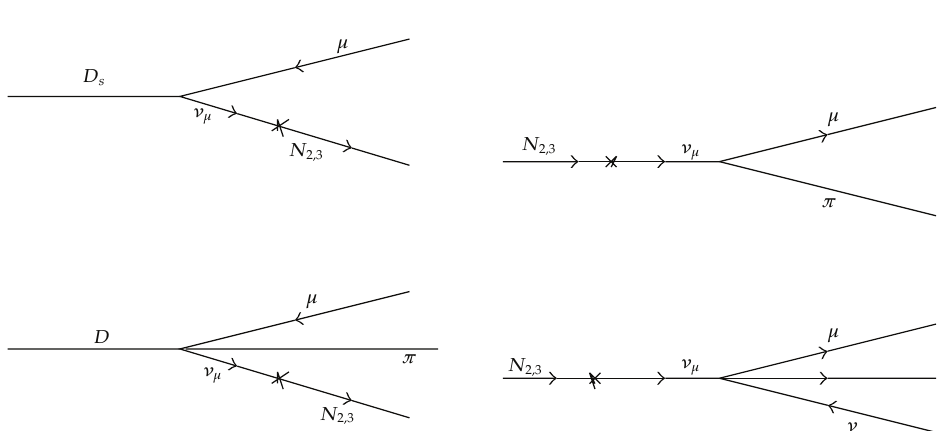
Figure 6: Left panel: Feynman diagrams of meson decays to heavy sterile neutrinos. Right panel: Feynman diagrams of sterile neutrino decays.